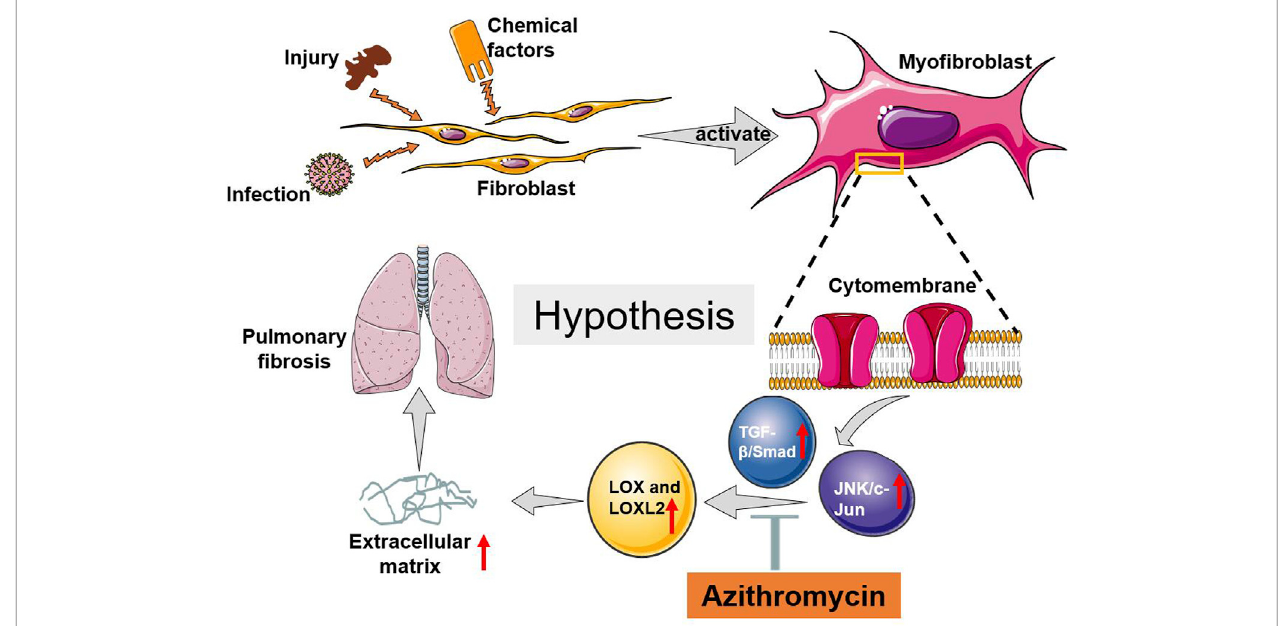
FIGURE 7 | The possible potential mechanism of AZM attenuated BLM induced pulmonary fi brosis in mice.